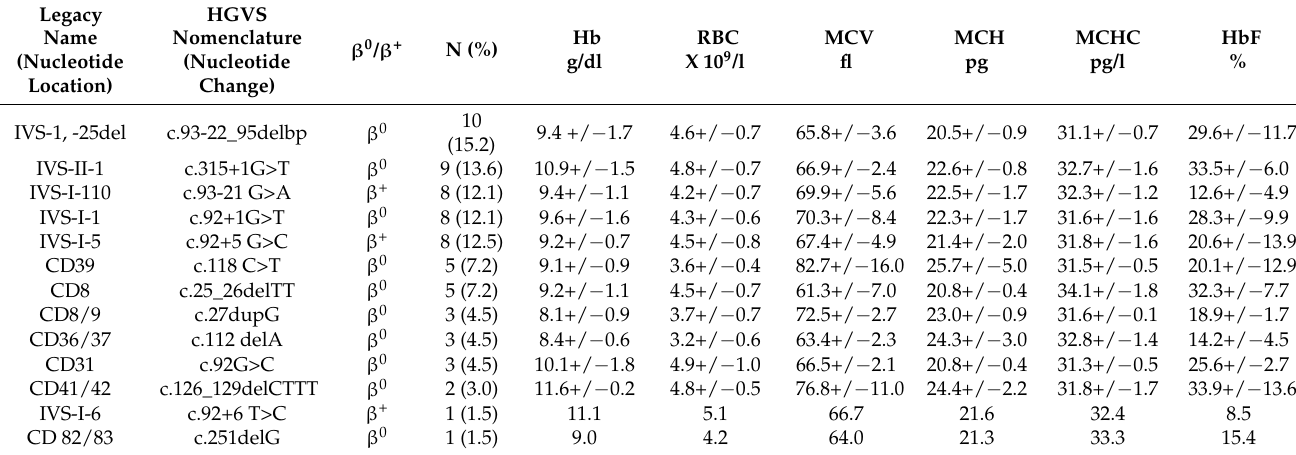
Table 4. Distribution of beta-thalassemia mutations in S β patients and the associated mean hematological values.